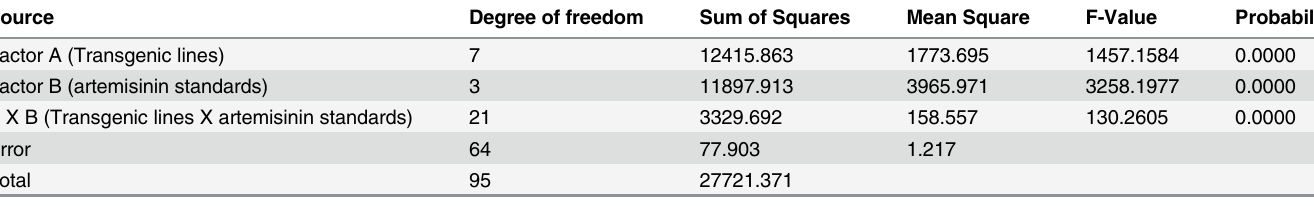
Table 1. Analysis of variance for quantitative analysis of artemisinin and